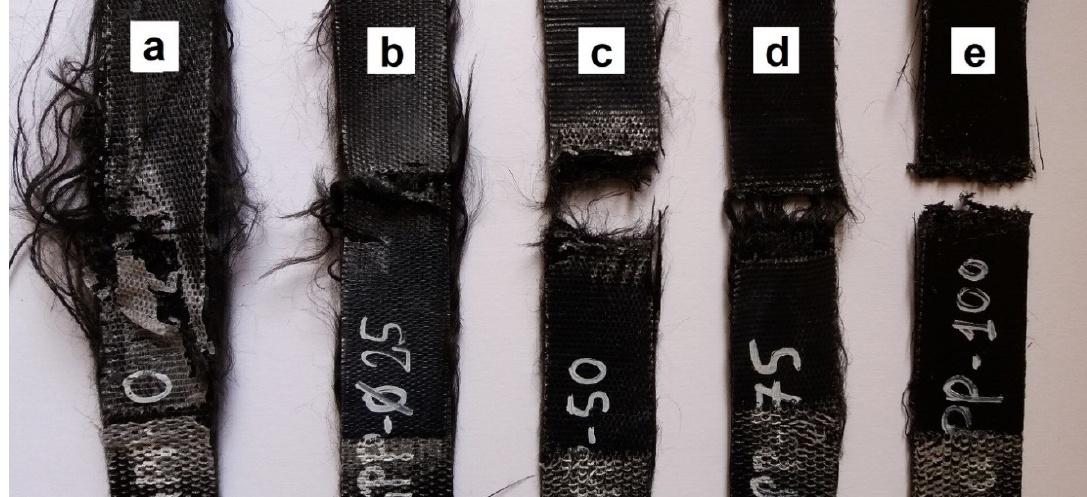
Figure 7. Typical failure behavior of ( a ) rPP, ( b ) APAO-25, ( c ) APAO-50, ( d ) APAO-75 and ( e ) APAO.